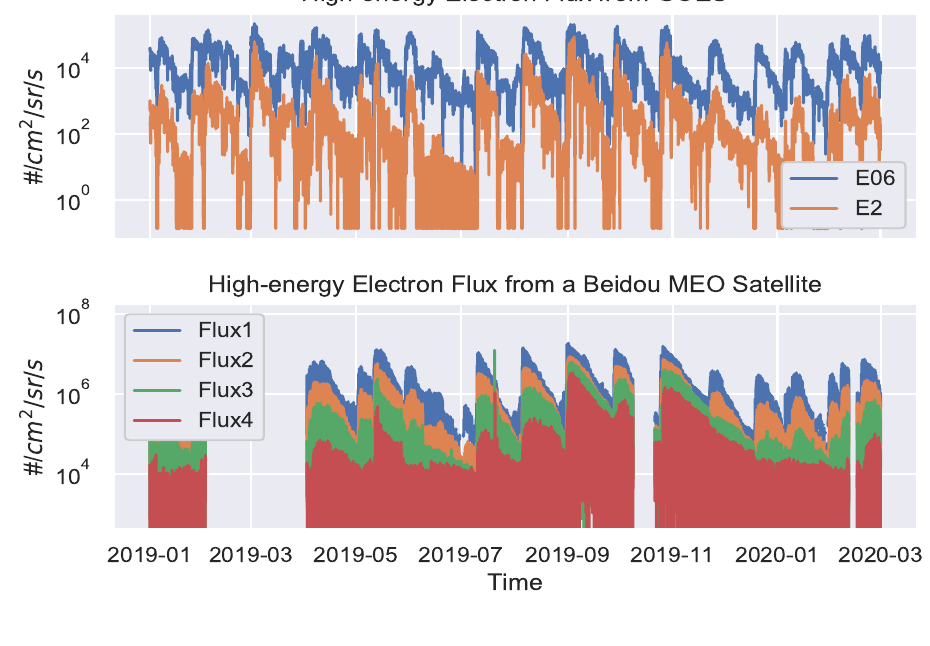
Figure 1. High-energy electron flux observations from 2019-01-01 to 2020-02-29 for GOES-15 over two energy channels (Top panel) and for a Beidou MEO satellite over four energy channels (Bottom